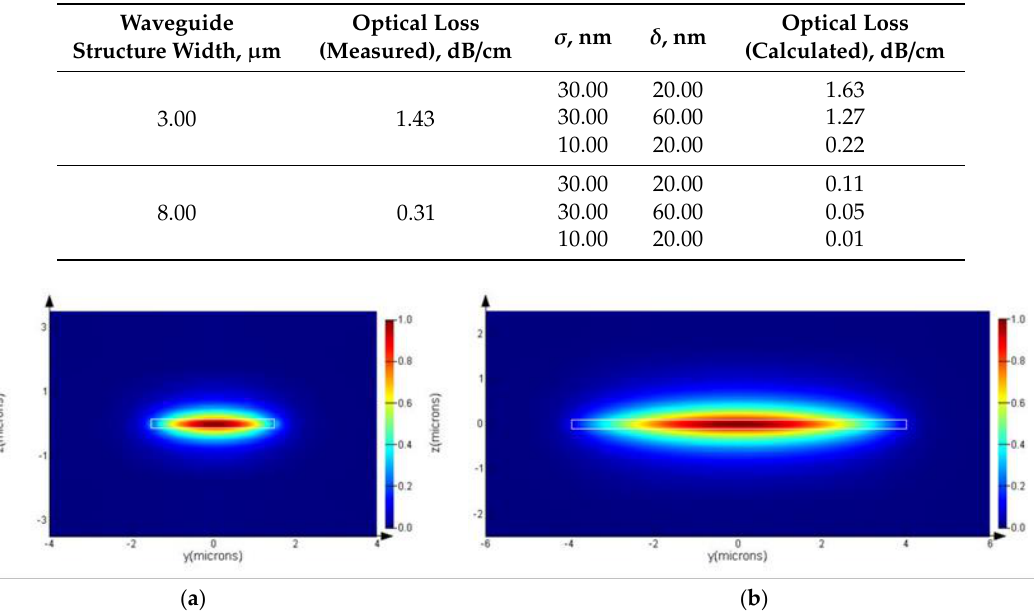
Figure 6. Allocation of the normalized amplitude of electric field (mode TE00) in waveguides of various widths for a waveguide with widths of 3 ( a ) and 8 µm ( b ). Table 3. Comparison of the measured and calculated attenuation of the TE00 mode in silicon nitride waveguides; —mean square deviation of roughness; —longitudinal size of roughness.